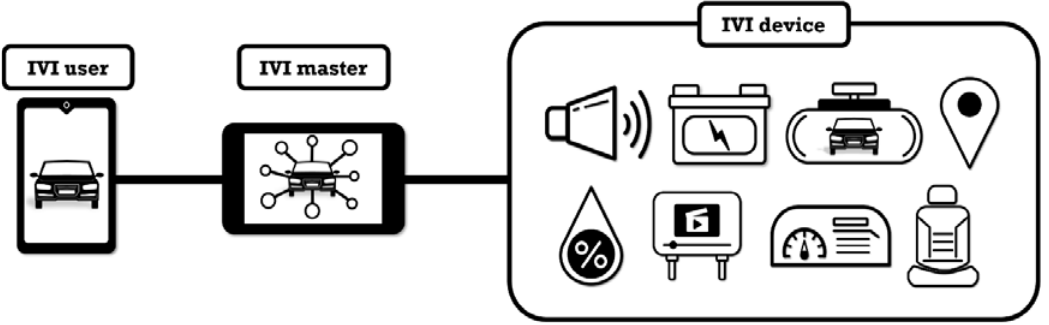
Figure 2. Centralized IVI (C-IVI) system based on IVI master .